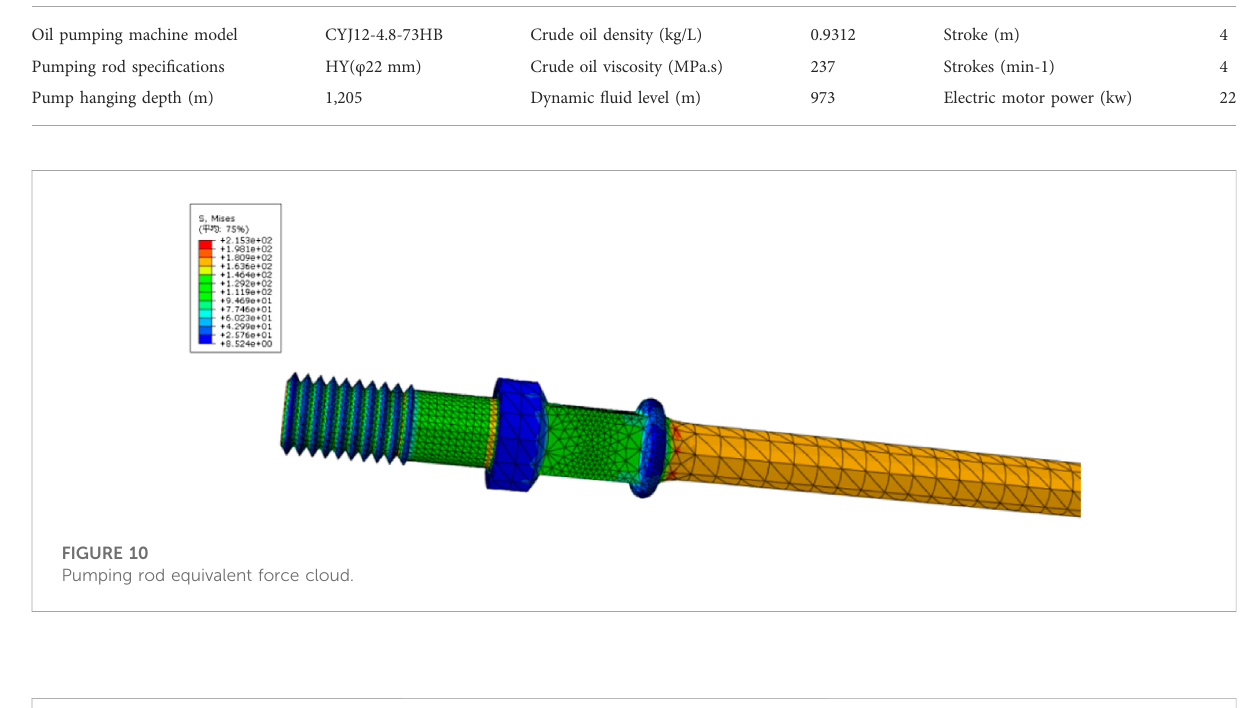
TABLE 3 Well production data.